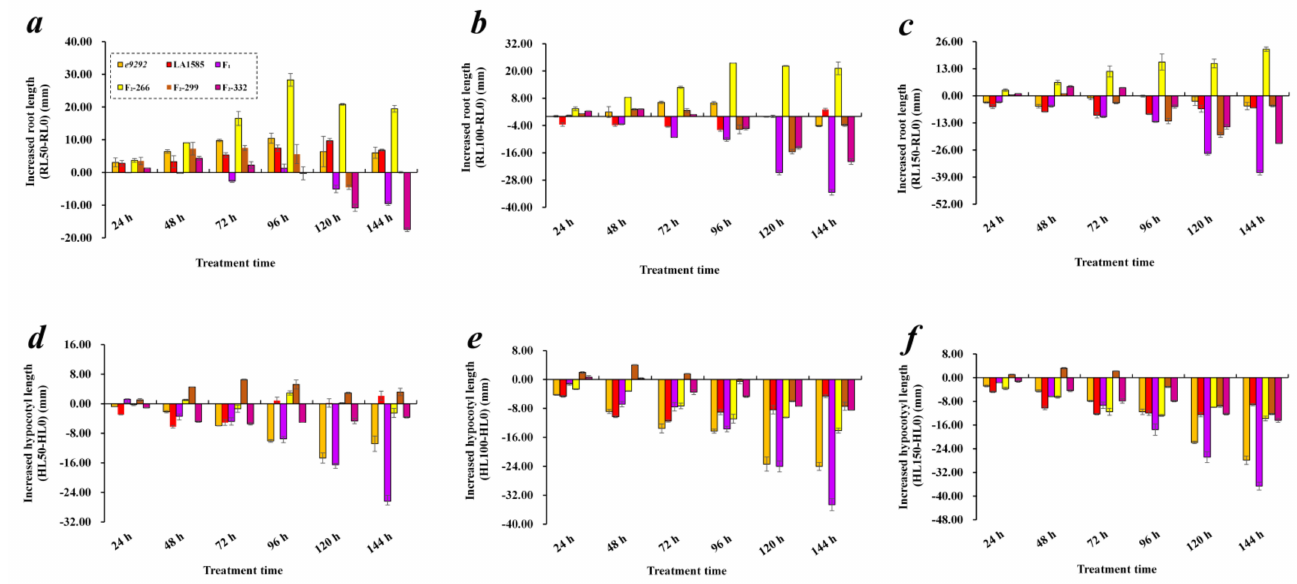
Figure 4. Mannitol stress affects the root and hypocotyl growth of tomato seedlings. ( a – c ) Differ- ences in the root length of seedlings with different genetic backgrounds between mannitol treat- ments (50 mmol/L to 150 mmol/L) and the control (0 mmol/L). ( d – f ) Differences in the hypocotyl length of seedlings with different genetic backgrounds between mannitol treatments (50 mmol/L to 150 mmol/L) and the control (0